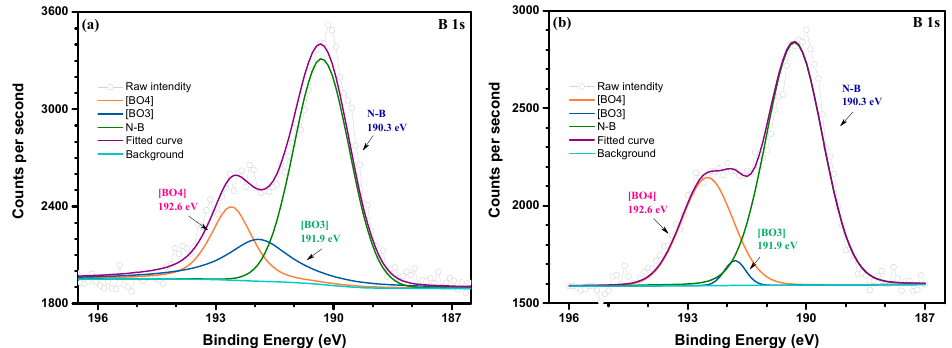
Figure 4. XPS spectrum of B 1 s for ( a ) TC0/CBN composite and ( b ) TC4/CBN composite sintered at 950 °C for 1 h. 950 ◦ C for 1